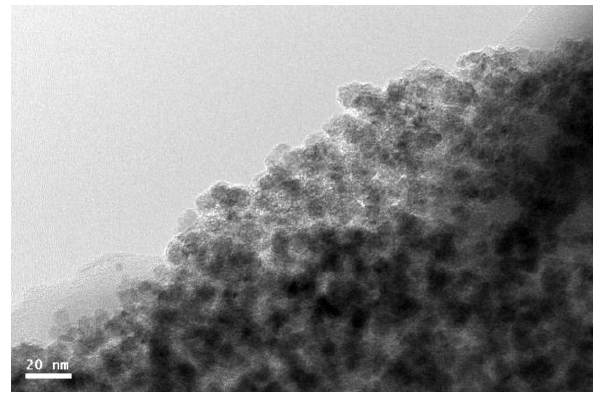
Figure 5. Transmission electron microscopy (TEM) micrograph of the nanoparticle film after annealing for 6 h.